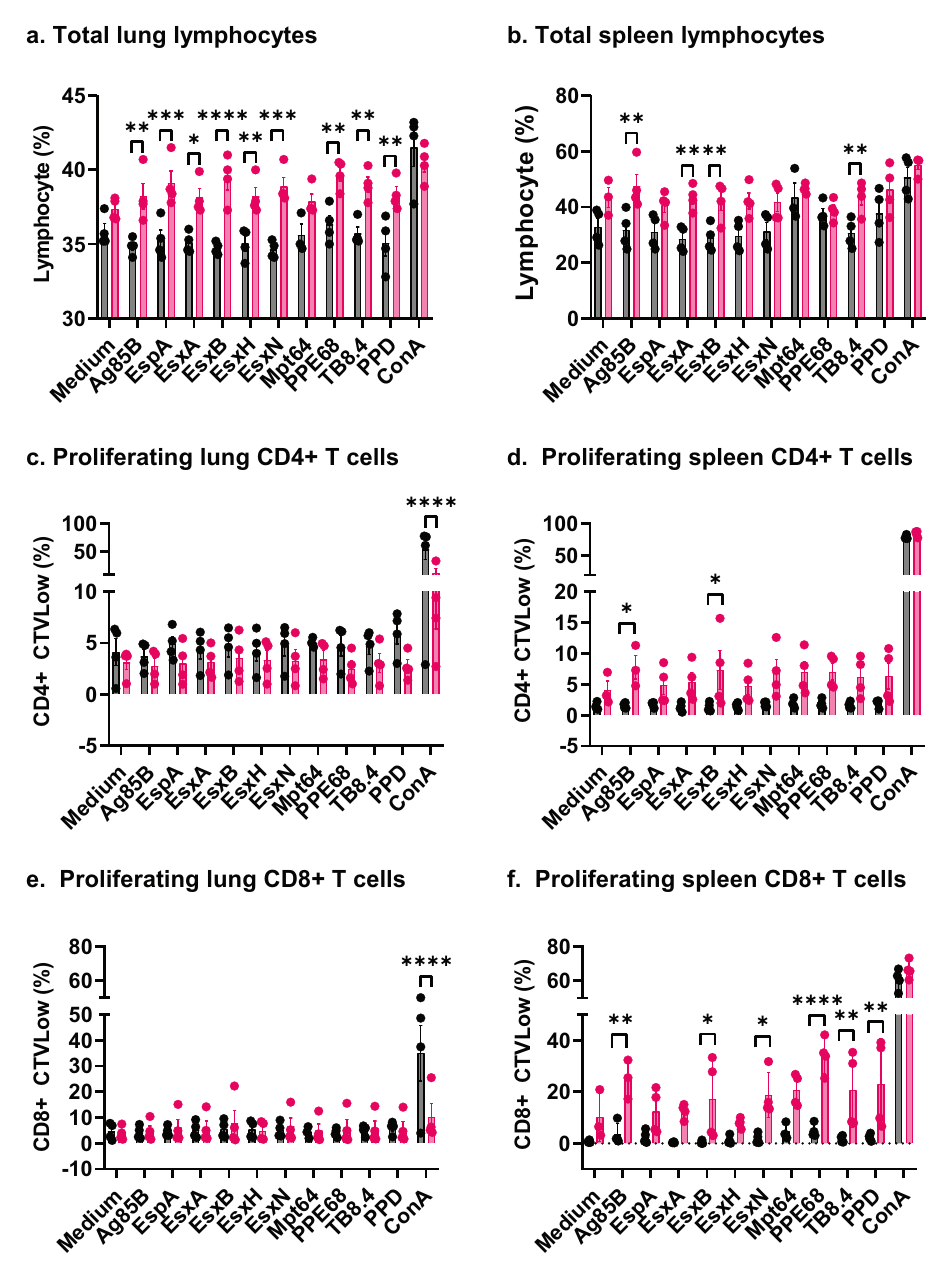
Fig. 9 Frequencies of all lymphocytes and proliferating CD4 + and CD8 + T cells in the lungs and spleens of guinea pigs immunized with LmVector or rLm9Ag. Guinea pigs ( n = 4/group) were immunized three times s.q. with LmVector (black) or rLm9Ag (pink) at Weeks 0, 3, and 6. Six days after the last immunization, guinea pigs were euthanized; their spleens and lungs removed; single cell suspensions of spleen and lung cells prepared and treated with Cell Tracer Violet (CTV), followed by incubation with medium alone (negative control), medium with addition of 1 µ g/ml per peptide of each of the 9 Mtb antigen peptide pools plus anti-CD28 monoclonal antibody (mAb), medium with addition of 5 µ g/ml of PPD protein plus anti-CD28 mAb, or medium with addition of 5 µ g/ml of ConA (positive control), as indicated beneath the horizontal axis, for 4 days. Subsequently, the cells were stained with Live/dead staining dye and surface markers of CD4-PE and CD8-FITC. Total lung lymphocytes ( a ) and total spleen lymphocytes ( b ) were gated by forward and side scatter patterns; proliferating lung CD4 + T cells ( c ), proliferating spleen CD4 + T cells ( d ), proliferating lung CD8 + T cells ( e ), and proliferating spleen CD8 + T cells ( f ) were gated by corresponding antibody staining. Values are means ± SEM. * P < 0.05; ** P < 0.01; *** P < 0.001; **** P < 0.0001 by two-way ANOVA with Sidak ’ s post multiple comparisons test (Prism 9.2.0). The experiment was repeated once with similar